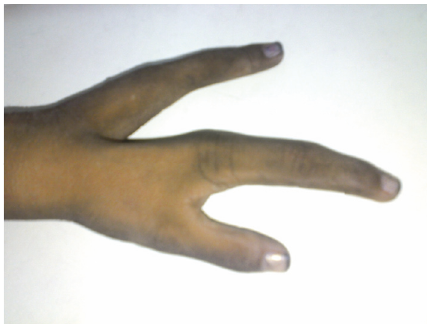
Figure 1: Split-hand malformation with absence of 3rd and 4th digits causing a lobster-claw